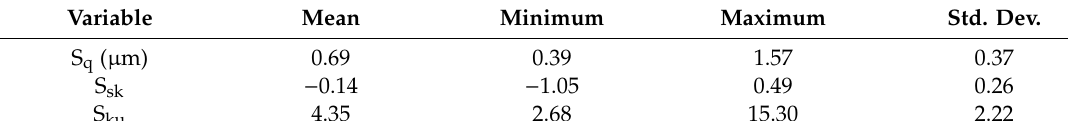
Table 7. Descriptive statistics—roughness.